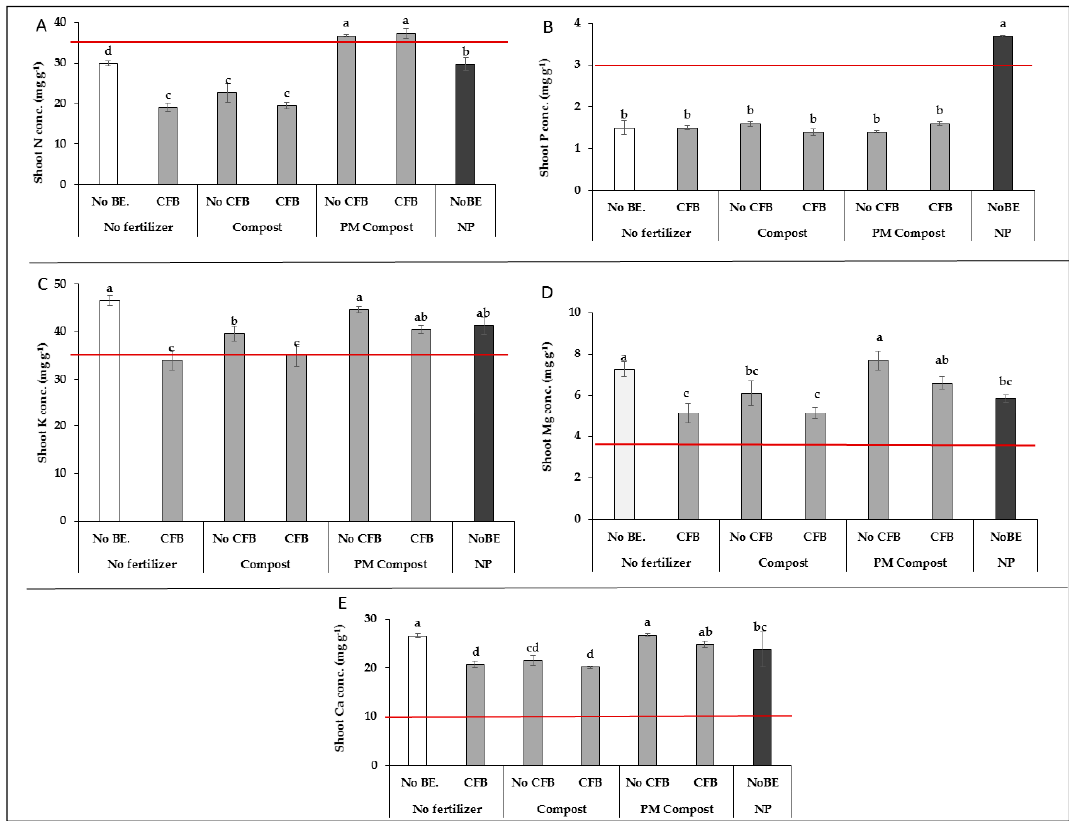
Figure 4. Effects of Combifector B inoculation on shoot N ( A ), P ( B ), K ( C ), Mg ( D ), and Ca ( E ) concentrations of 7-weeks-old tomatoes on pH 7.8 soil supplied with different fertilizers (CFB = Combifector B, PM = poultry manure, NP = calcium nitrate plus superphosphate., The red lines represent the deficiency thresholds for nutrient tissue concentrations [22]. Means and SE of five replicates. Significant treatment differences are indicated by different letters (T-grouping (LSD) at p = 0.05). * = significant difference compared with the non-inoculated control (NoBE) within the same fertilizer treatment ( t -test at p < 0.05). Table 2. Effects of Combifector B inoculation on the shoot accumulation of N, P, K, Mg, and Ca of 7- week-old tomatoes on pH 7.8 soil supplied with different fertilizers. (CFB = Combifector B, PM = Poultry Manure, NP = calcium nitrate plus superphosphate). Means and SE of five replicates. Significant treatment differences are indicated by different letters (T-grouping (LSD) at p = 0.05). * = significant difference compared with the non-inoculated control (NoBE) within the same fertilizer treatment ( t -test at p < 0.05).